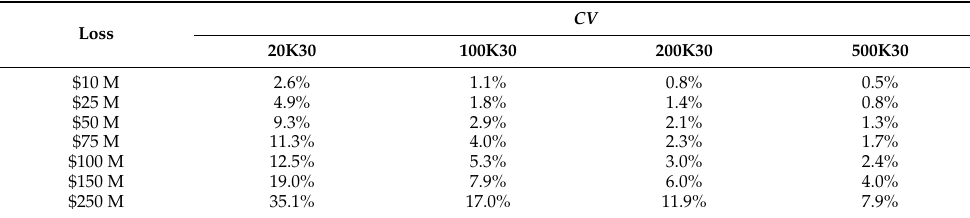
Table 11. Comparisons of the CV of the dollar losses for the Model Portfolio for different Bootstrap approaches depending on the original loss Monte Carlo simulation sizes of N = 20 K, 100 K, 200 K and 500 K. 500K30 means 30 resamples of 500 K each.